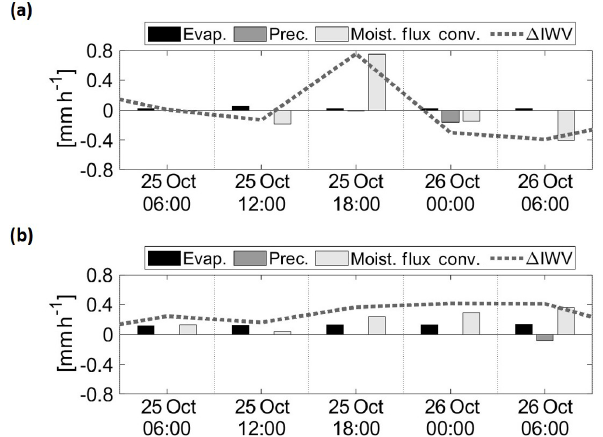
Figure 7. Temporal evolution of the moisture budget terms, vari- ation of IWV ( (cid:49) IWV), moisture flux convergence, evapotranspira- tion and precipitation. Hourly values are given. The spatial averages are performed over the investigation areas NA (a) and MED (b) . The values are obtained from